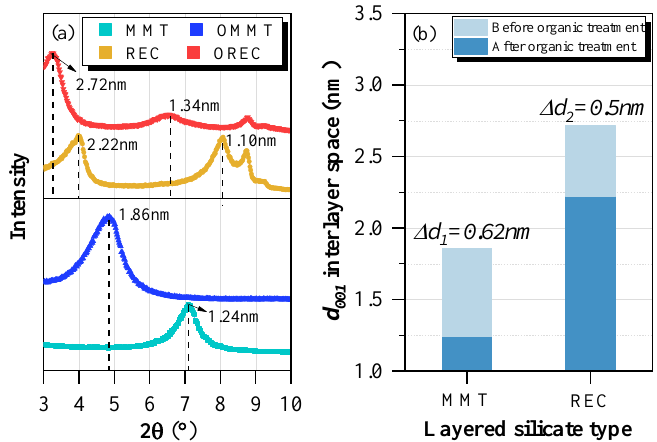
Figure 3. The XRD test result for untreated and treated layered silicates: ( a ) Diffraction angle; ( b ) interlayer space ( d 001 ).